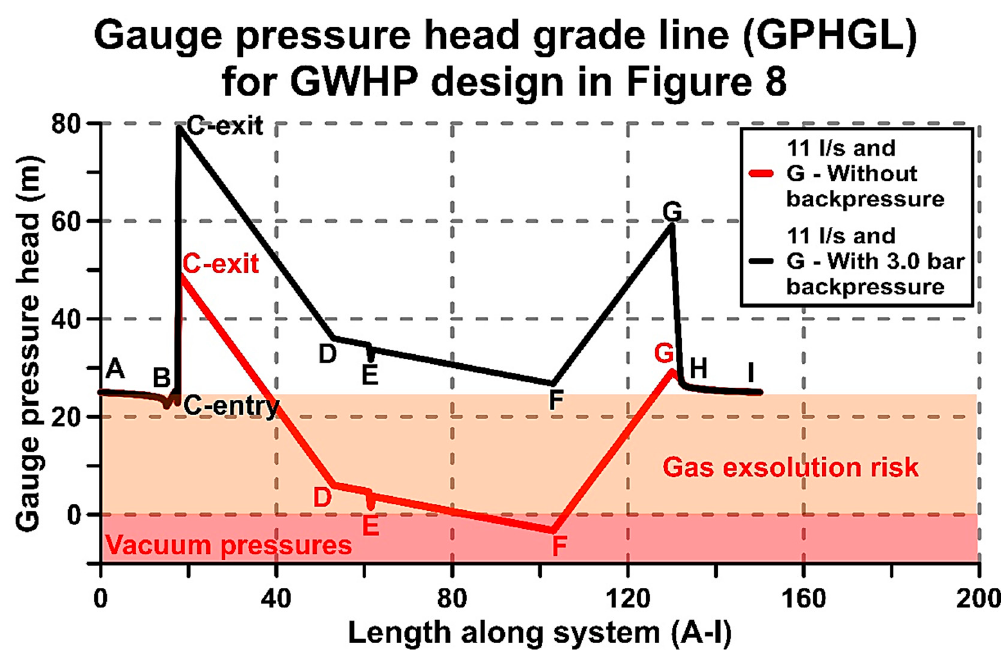
Figure 9. Pressure grade line (GPHGL) for the groundwater flow line A–I in Figure 8. Groundwater flow rate is 11 l/s for both cases. Backpressure valve is 3.0 bar (30 m) and is installed at the injection pipe exit (G).